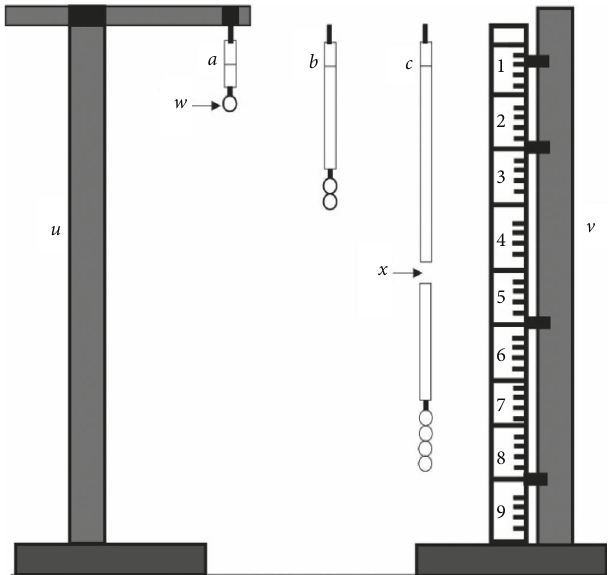
Figure 1: Determination of Young ’ s modulus: ( u ) fi xed support and clamp for the rubber strip, ( v ) support for the ruler/ measuring system, ( w ) mass load ( a , b , and c ) rubber strip under di ff erent loading level, and ( x ) point of rubber